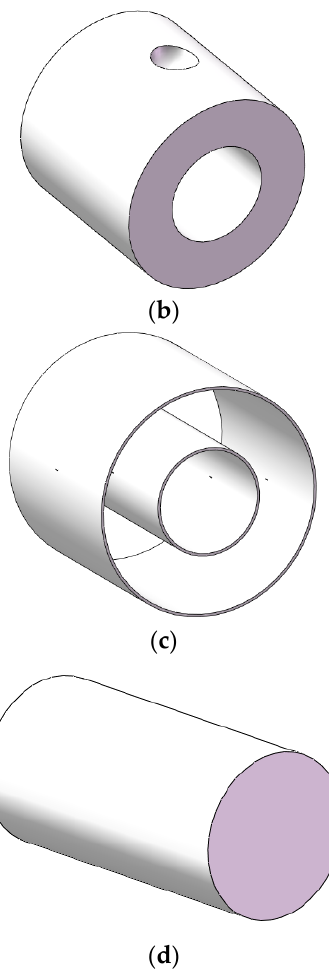
Figure 3. Schematic diagram of computational domains. ( a ) sound source zone model (near the leakage hole). ( b ) sound propagation zone model (annulus region). ( c ) pipe model. ( d ) exterior zone model for sound propagation (oil casing pipe).